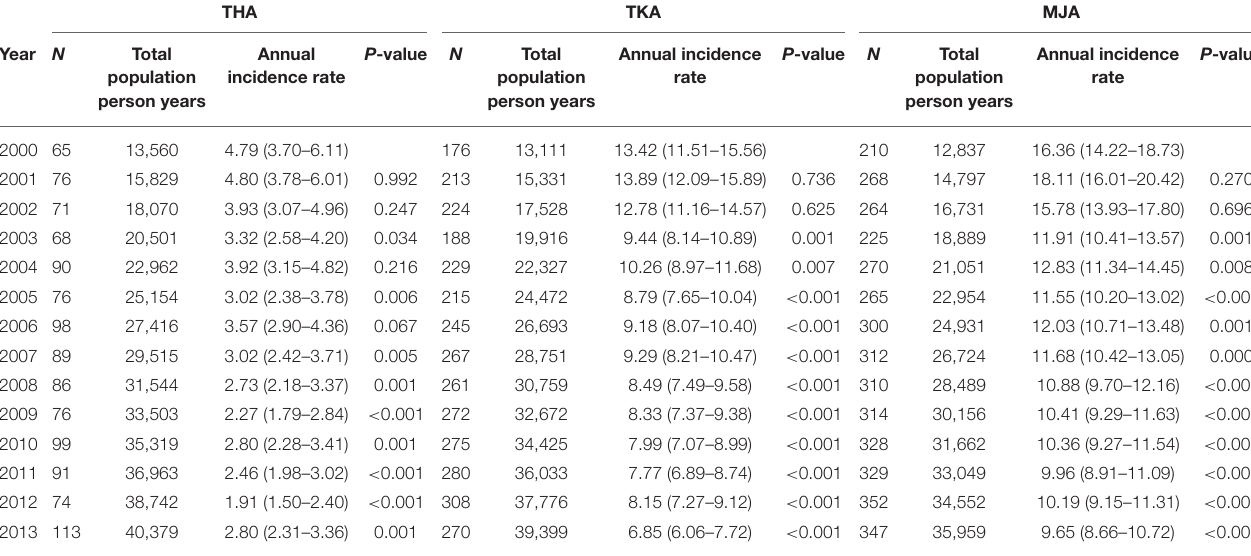
TABLE 4 | Annual numbers and incidence rates [per 1,000 person years (pyrs)] compared to year 2,000 among patients with rheumatoid arthritis receiving total hip arthroplasty (THA), total knee arthroplasty (TKA), and major joint arthroplasty (MJA), respectively.